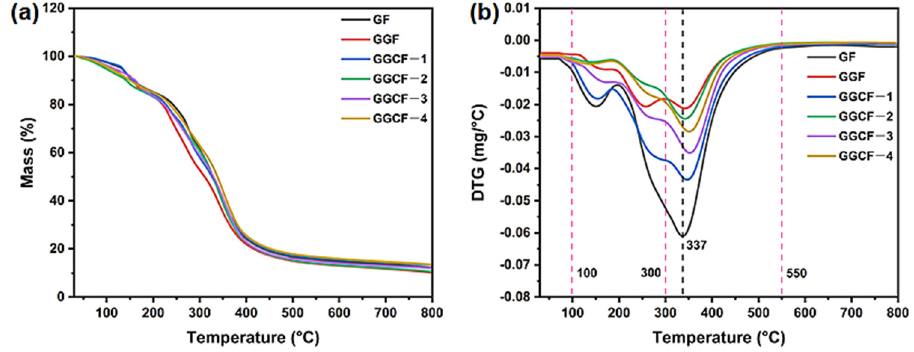
Figure 7. TG ( a ) and DTG curves ( b ) of GF, GGF, and different